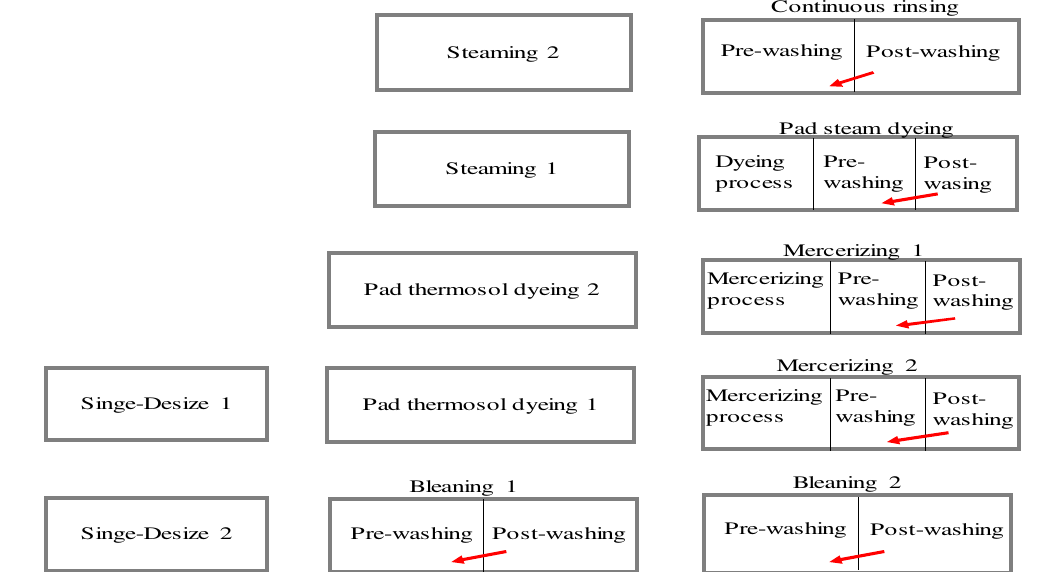
Fig. 6: Textile Wet-Processing machines and processes layout at Yunus Textile Mills. Red arrows are related to the heat flux and hot wastewater flow. Table 1: Details of YTM power and steam generation equipments